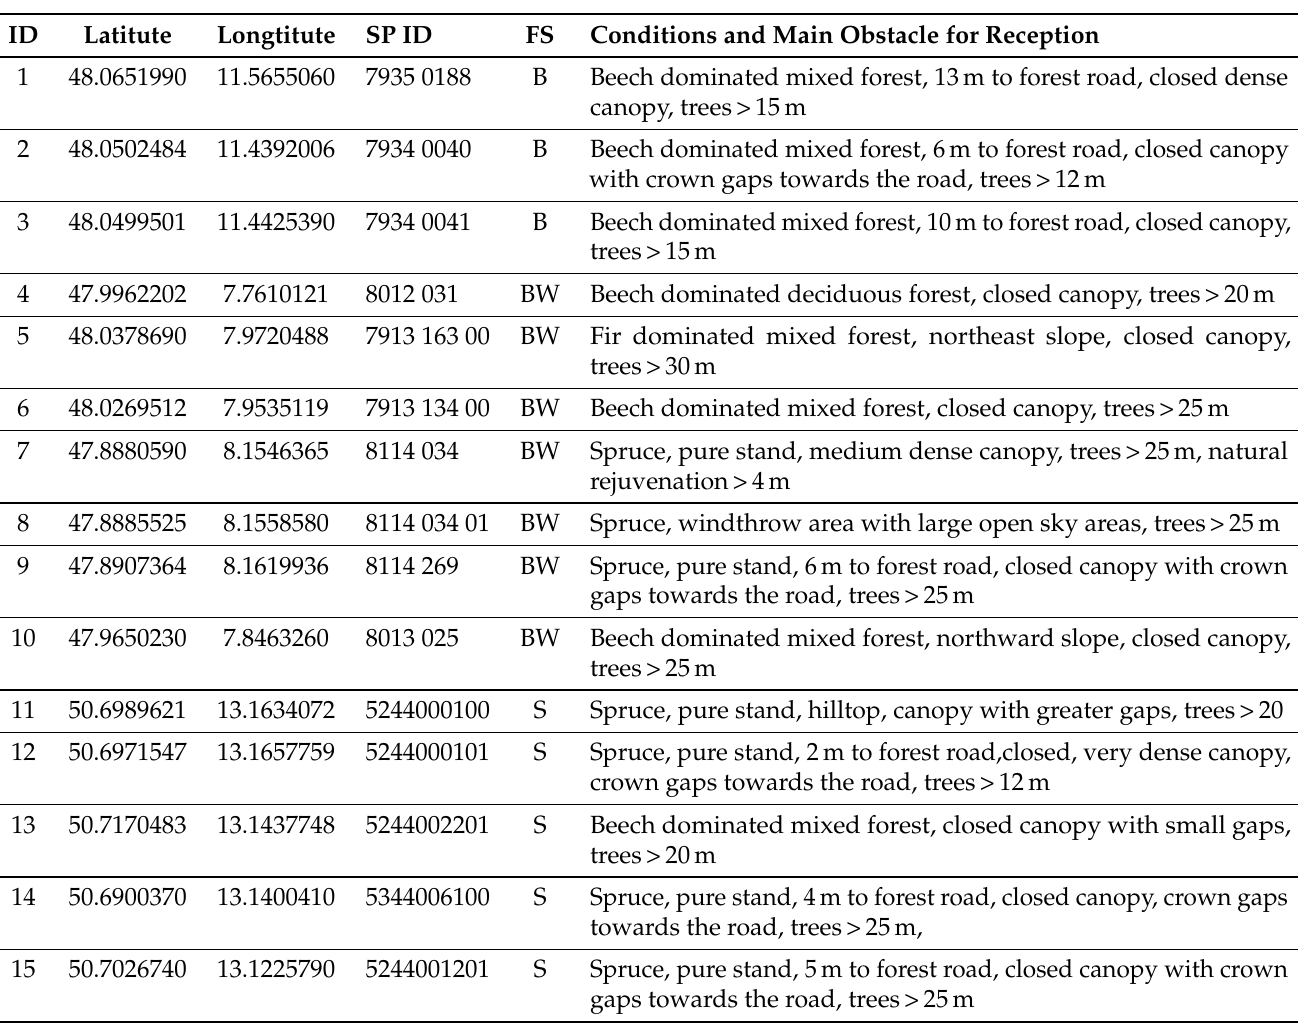
Table 2. Characteristics of the different study sites (SP ID: Official ID of the local survey